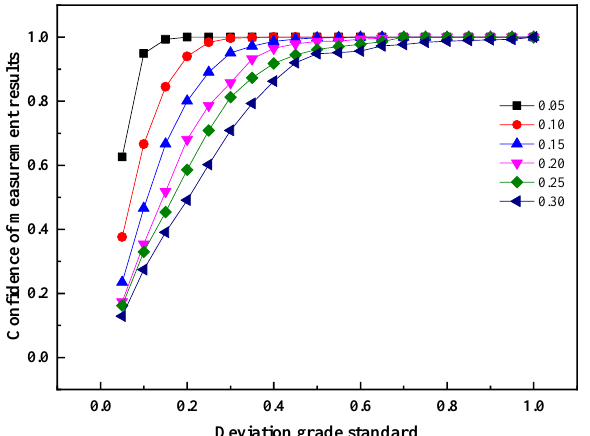
Figure 32. Relationship between deviation grade standard and confidence of measurement results under different relative standard deviation of velocity at mean velocity 1.35 m/s.